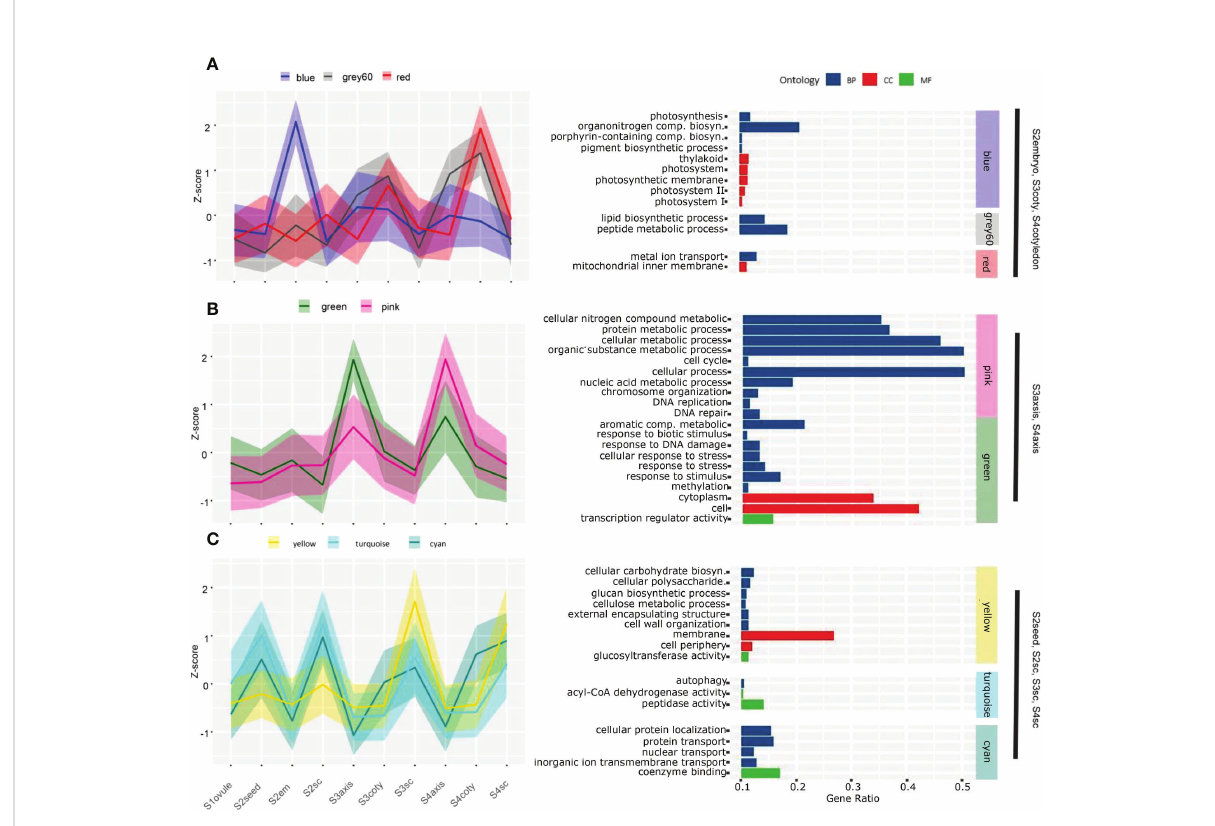
FIGURE 2 Gene co-expression pattern of each module in the course of the viviparous process. Gene expression levels in the different modules strongly correlated to certain tissues. A solid line represents the Z-score of total expression counts of all genes in the module; shadows delineate the SDs, and colors correspond to the module name. (A) The blue, grey60 and red modules are highly expressed in S2embryo, S3cotyledon and S4cotyledon. (B) The green and pink modules expressed higher in S3axis and S4axis than in other tissues. (C) Three modules that higher expressed in seed coats tissue; among them, the yellow module expressed maximum in S3sc and S4sc, while turquoise and cyan are higher in S2seed and S2sc. Enriched GO analysis of each module are given on the right-hand side panels, and the whole enrichment result was attached in Table